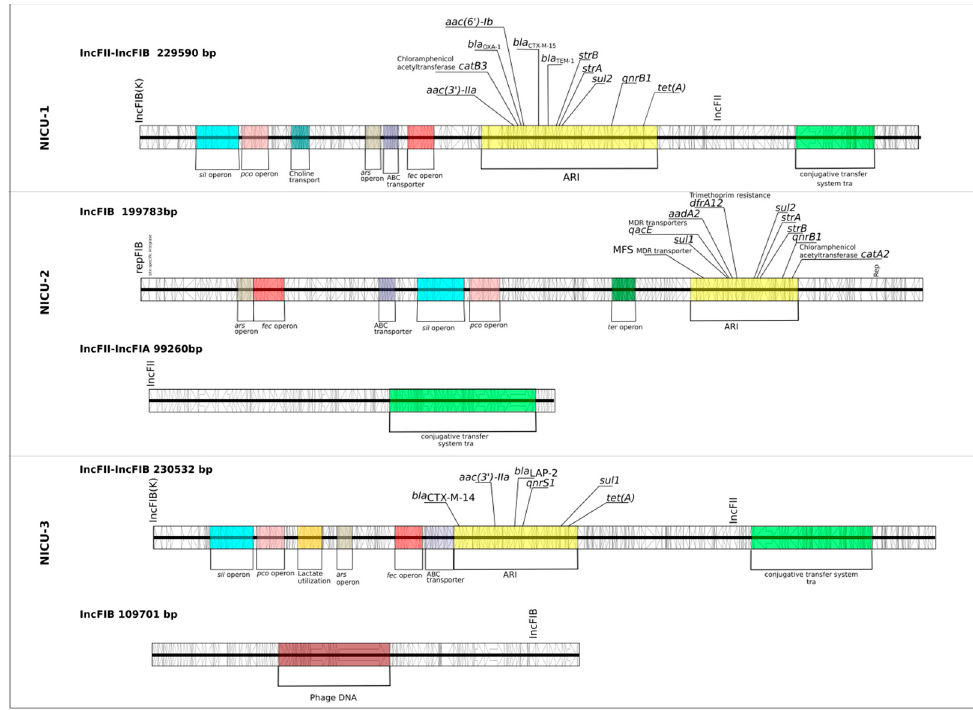
Figure 3. Schematic view of complete plasmids (over 10 Kbp) found by whole genome sequencing of dominant clones in outbreaks in three neonatal intensive care units. Antibiotic resistance genes and major operons are annotated.